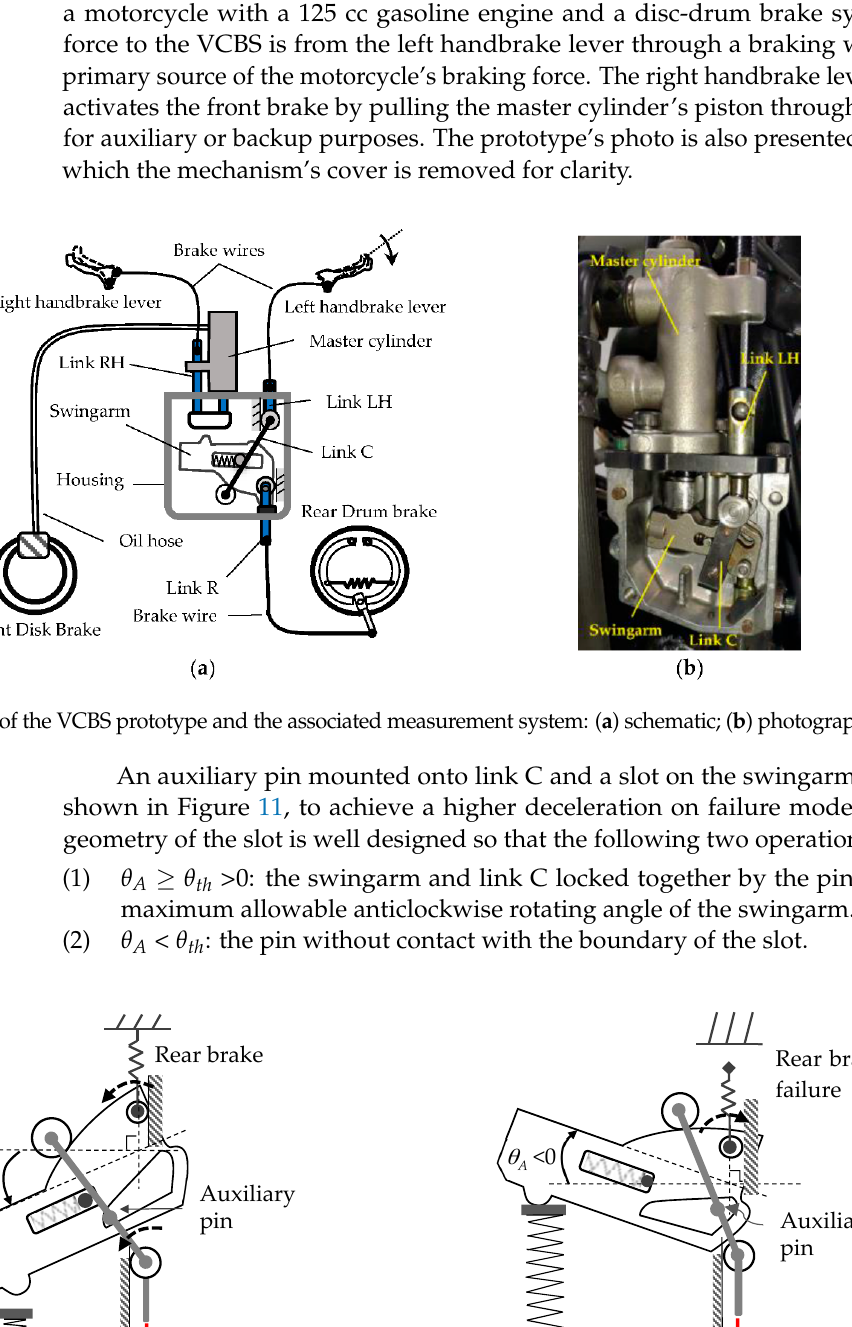
Figure 9. The BFD curves of different spring rates matching with the new designed cam profile. ( a ) Curves A~C: k s 1 = 4, 8, 12 N/mm with k s 2 = 0.08 N/mm 3 ; ( b ) curves D~F: k s 2 = 0.06, 0.09, 0.14 N/mm 3 with k s 1 = 8 N/mm .